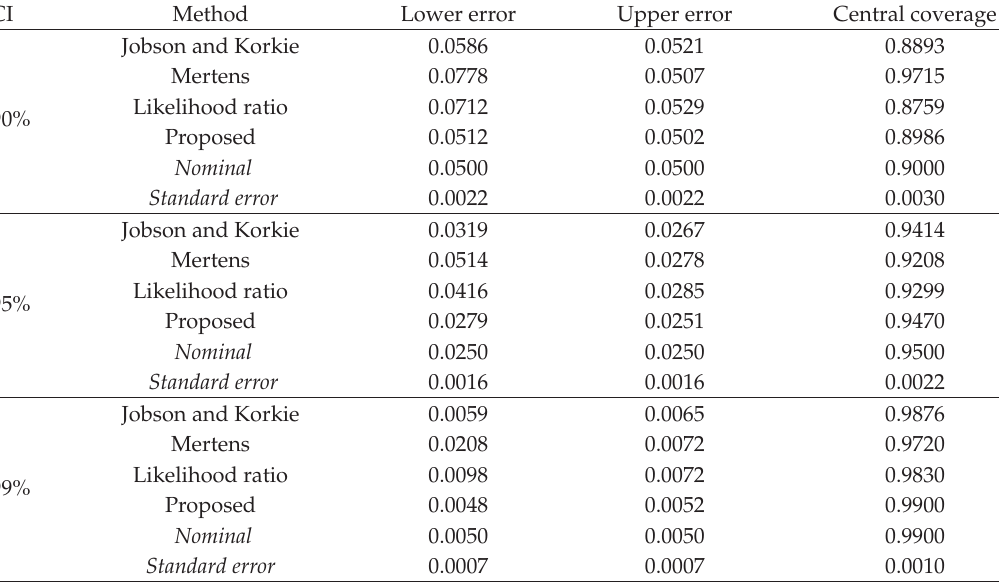
Table 5: Results for simulation study for fund for n (cid:6) 12.